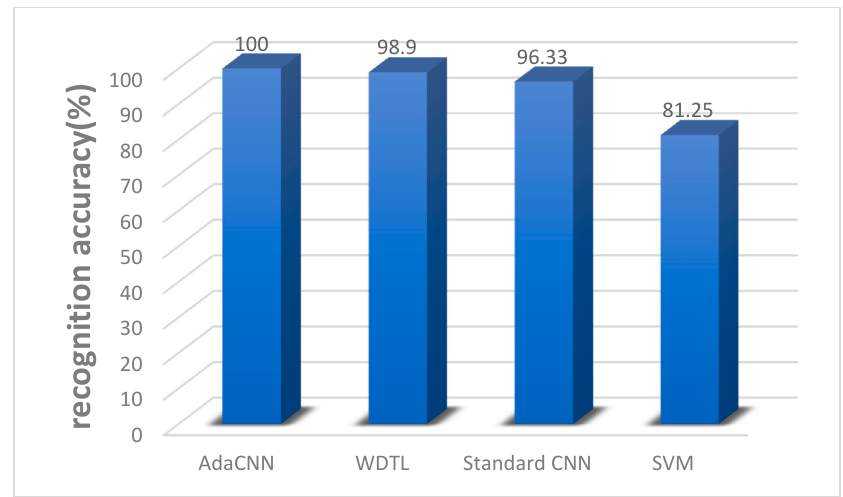
Figure 5. Accuracy of knowledge transfer under different working conditions.